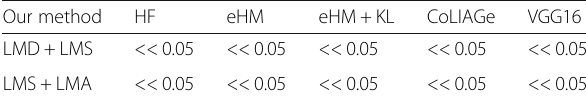
Table 9 Wilcoxon signed-rank test between AUC scores of our methods and the typical methods Our method